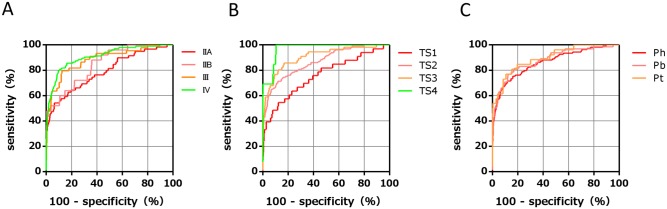
ROC curves of the PFAA index with different tumor stages, sizes, and locations.(A) ROC curves of the PFAA index in stage IIA (red), stage IIB (pink), stage III (orange), and stage IV (yellow–green), respectively. (B) ROC curves in TS1 (red), TS2 (pink), TS3 (orange), and TS4 (yellow–green), respectively. TS1 ≤ 2.0 cm, 2.0 cm < TS2 ≤ 4.0 cm, 4.0 cm < TS3 ≤ 6.0 cm, and TS4 > 6.0 cm. (C) ROC curves in the pancreatic head (red), body (pink), and tail (orange), respectively.